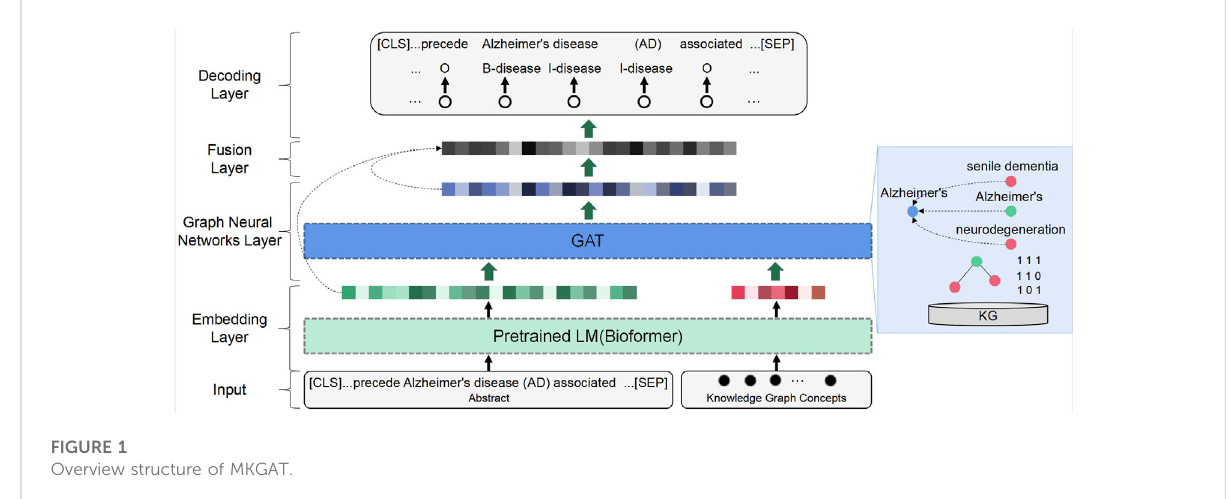
FIGURE 1 Overview structure of MKGAT.